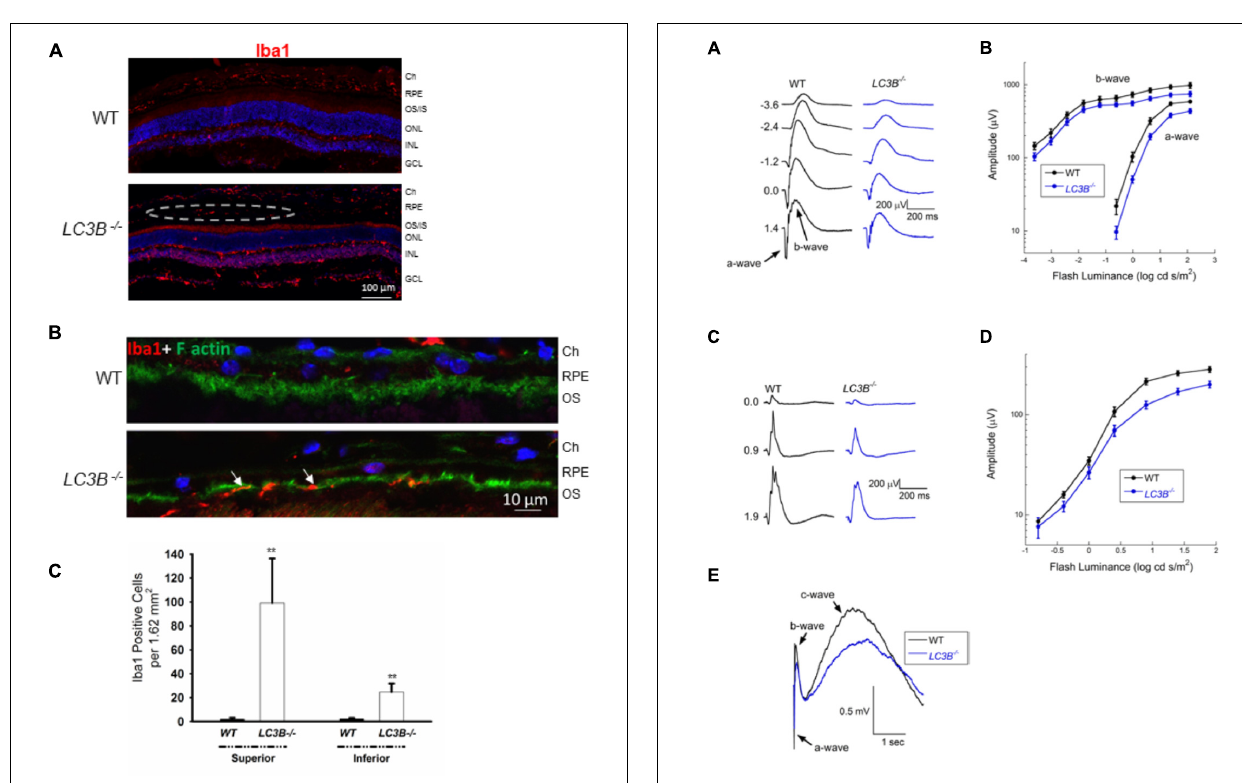
FIGURE 7 | Loss of LC3B contributes to pro-inflammatory environment. (A) Immuno-staining of WT and LC3B − / − retinal sections with Iba1 showing numerous Iba1 positive cells (red, marked by dotted oval) in the L3CB − / − retina on the apical side of RPE, nuclei (blue); age 24 months. (B) Higher mag images showing the Iba1 positive cells (red) near the apical RPE, counterstained with phalloidin (green) to label the actin cytoskeleton; age ∼ 30 months. (C) Number of Iba1 positive cells per field in the superior and inferior RPE. Values are mean ± SEM from 4 individual mice ( ∼ 18 months), ∗∗ p < 0.050.